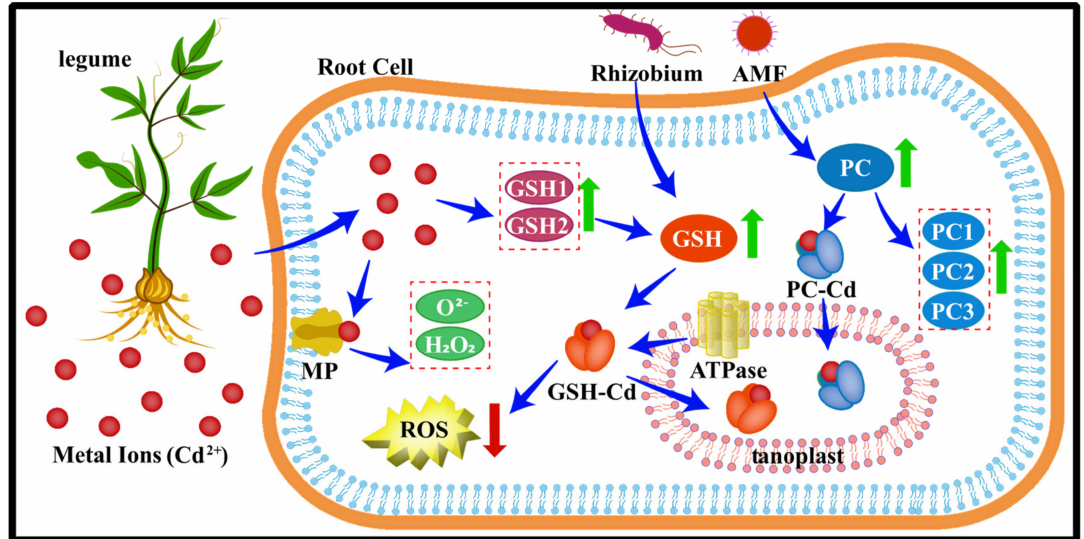
Figure 6. After the entry of metal ions (mainly representing Cd 2+ ) into cells, GSH1 and GSH2 genes (two enzymes involved in encoding GSH synthesis: γ EC synthase and GSH synthase) were up- regulated under the action of Cd. GST catalyzes the nucleophilic attack of GSH on the electrophilic group of Cd to form a GSH-Cd complex. PC is synthesized from GSH in a reaction catalyzed by PC synthase. The tonoplast ATPase sequesters GSH-Cd and PC-Cd complexes in the vacuole, thereby helping to mitigate Cd toxicity and avoid cellular metabolic toxicity. In addition, proteins on cell membranes interact with metal ions to reduce oxidative stress damage in plants. The green arrow shows an increase in the content and the red arrow shows a decrease in the content in the figure. The blue arrow shows the protective activities that occur within a cell to reduce the toxicity of a metal ion when it